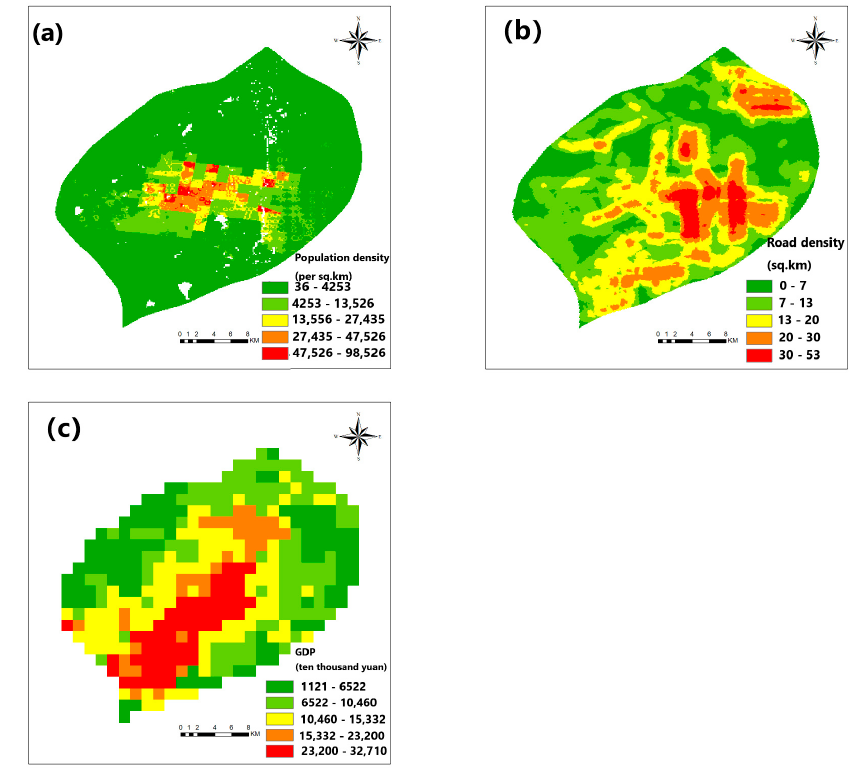
Figure 4. Population density ( a ); road density ( b ); GDP ( c ).